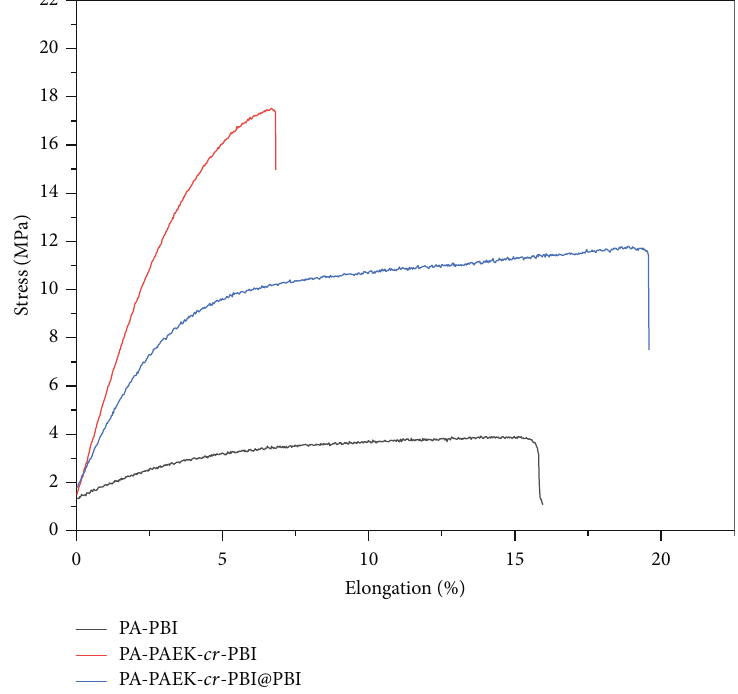
Figure 10: Mechanical properties of PA-doped membranes at room temperature. Table 2: Summary of proton conductivities and mechanical properties of PA-doped membranes.